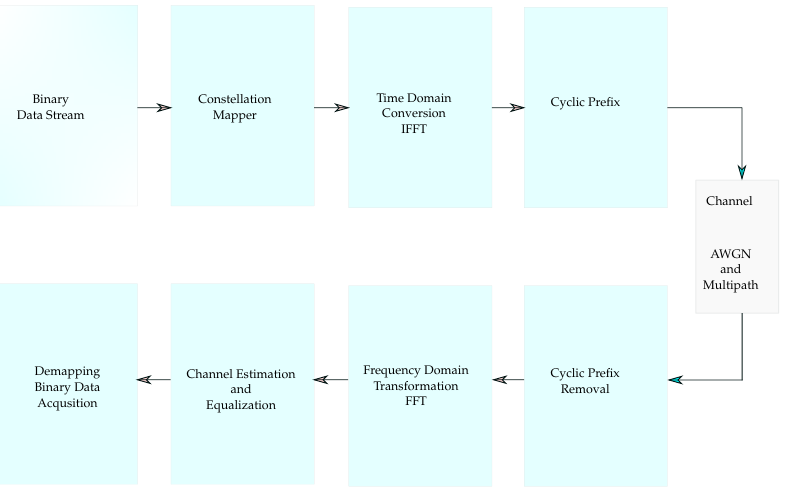
Figure 1. Conventional OFDM